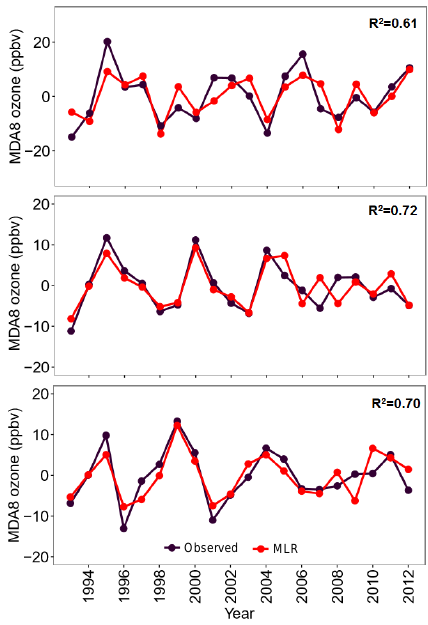
Figure 7. Time series of observed HGB-mean MDA8 ozone (black line) and MLR-regressed ozone (red line) in June (top), July (mid- dle), and August (bottom). The data presented are